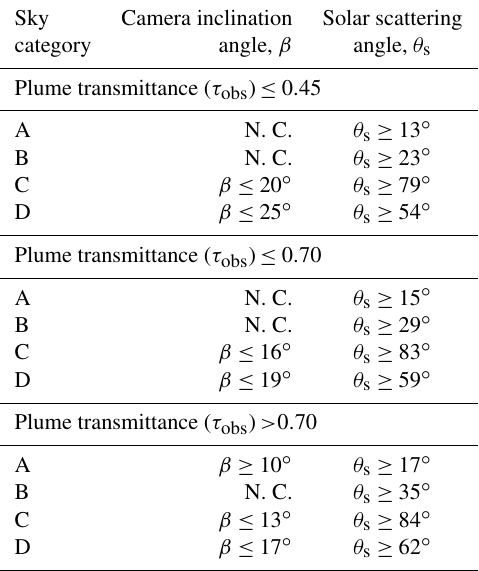
Table 3. Summary of constraints regarding camera pointing relative to the horizon and sun as a function of plume transmittance ( τ obs ). Compliance with these heuristics ensures that uncertainty in sky- LOSA-computed soot mass column density is low (CV 95 ≤ 17%), regardless of solar zenith angle ( Z s ). (N. C. denotes “no con-